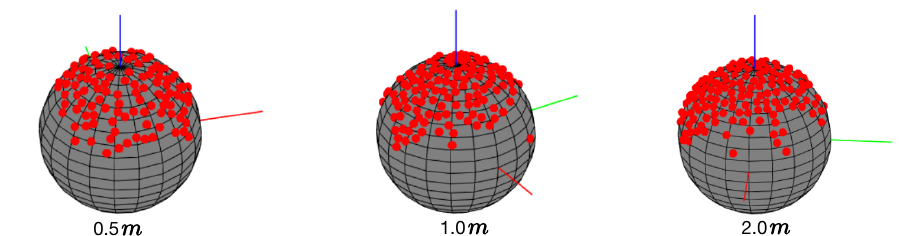
Figure 10. Viewpoints of Object1 in different camera distances.